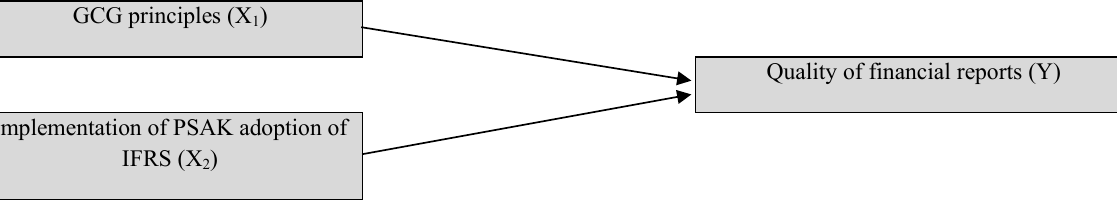
Fig.1. Research Conceptual